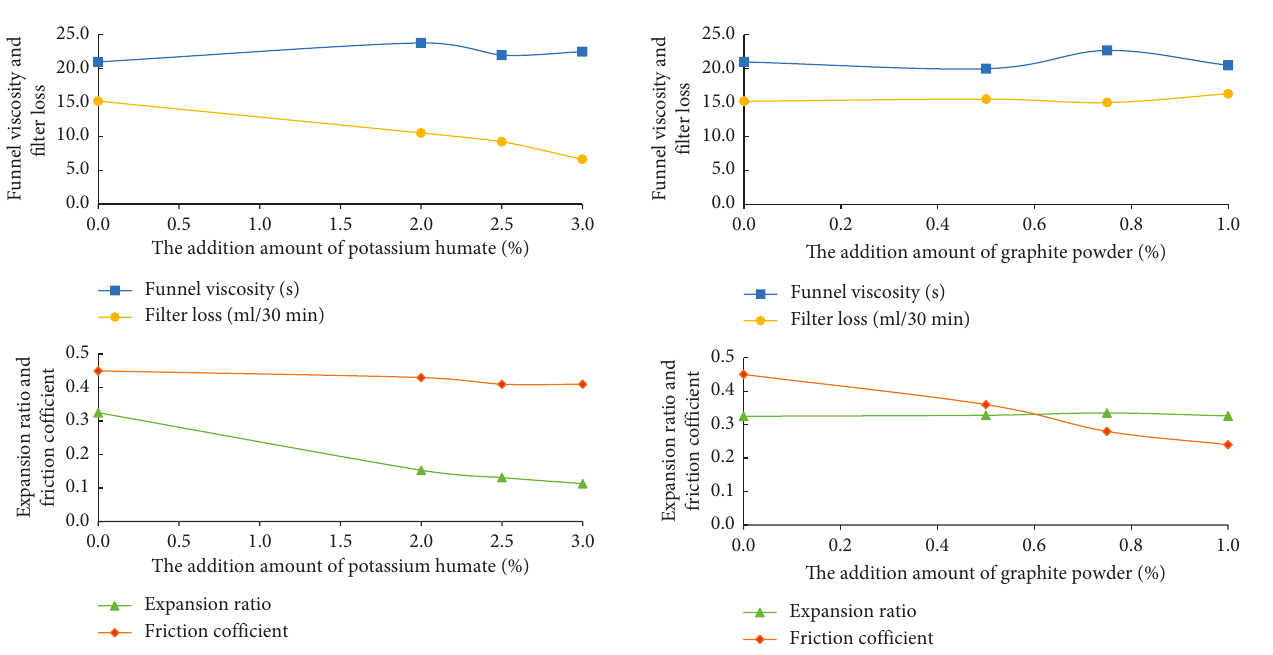
Figure 5: The effect of graphite powder on the slurry